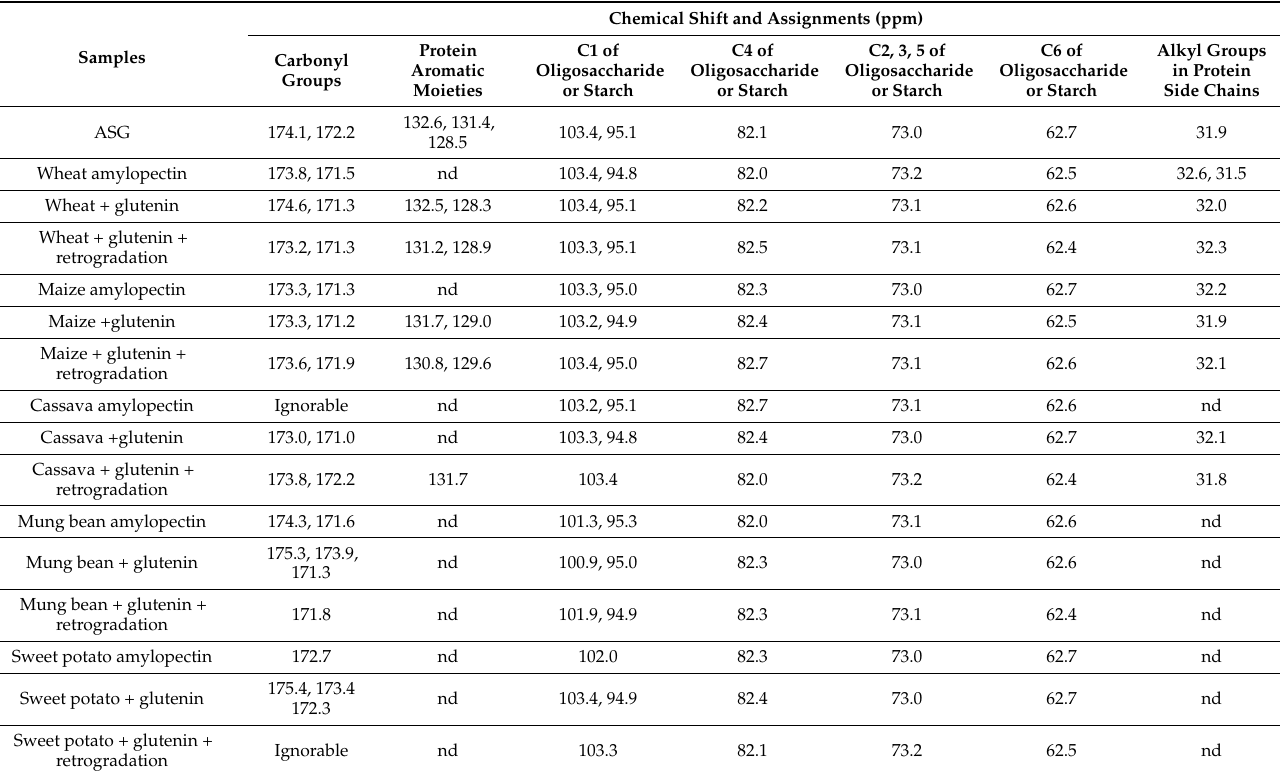
Table 5. Assignments of the high-resolution 13 C solution-state NMR spectra of ASG before and after being mixed with different amylopectins, both before and after